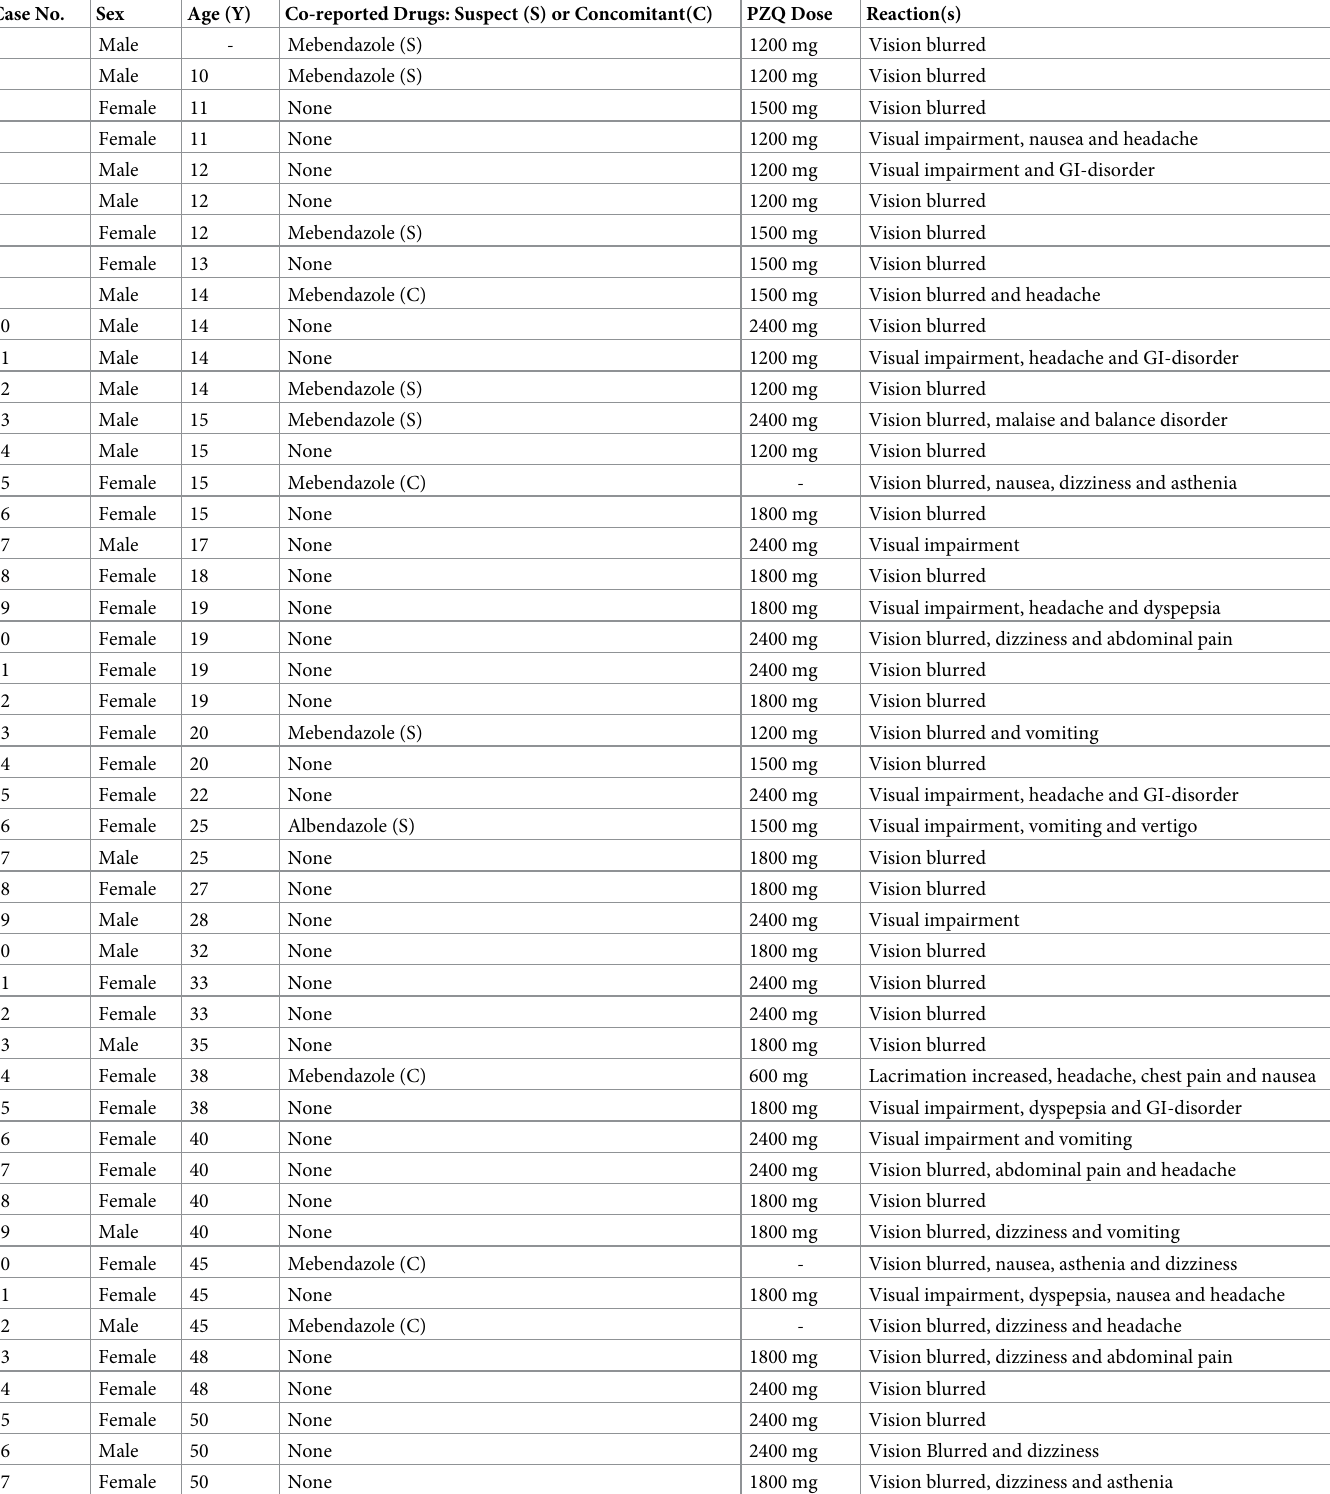
Table 1. Summary of selected variables for the 61 cases of visual abnormalities related to praziquantel (PZQ). Case